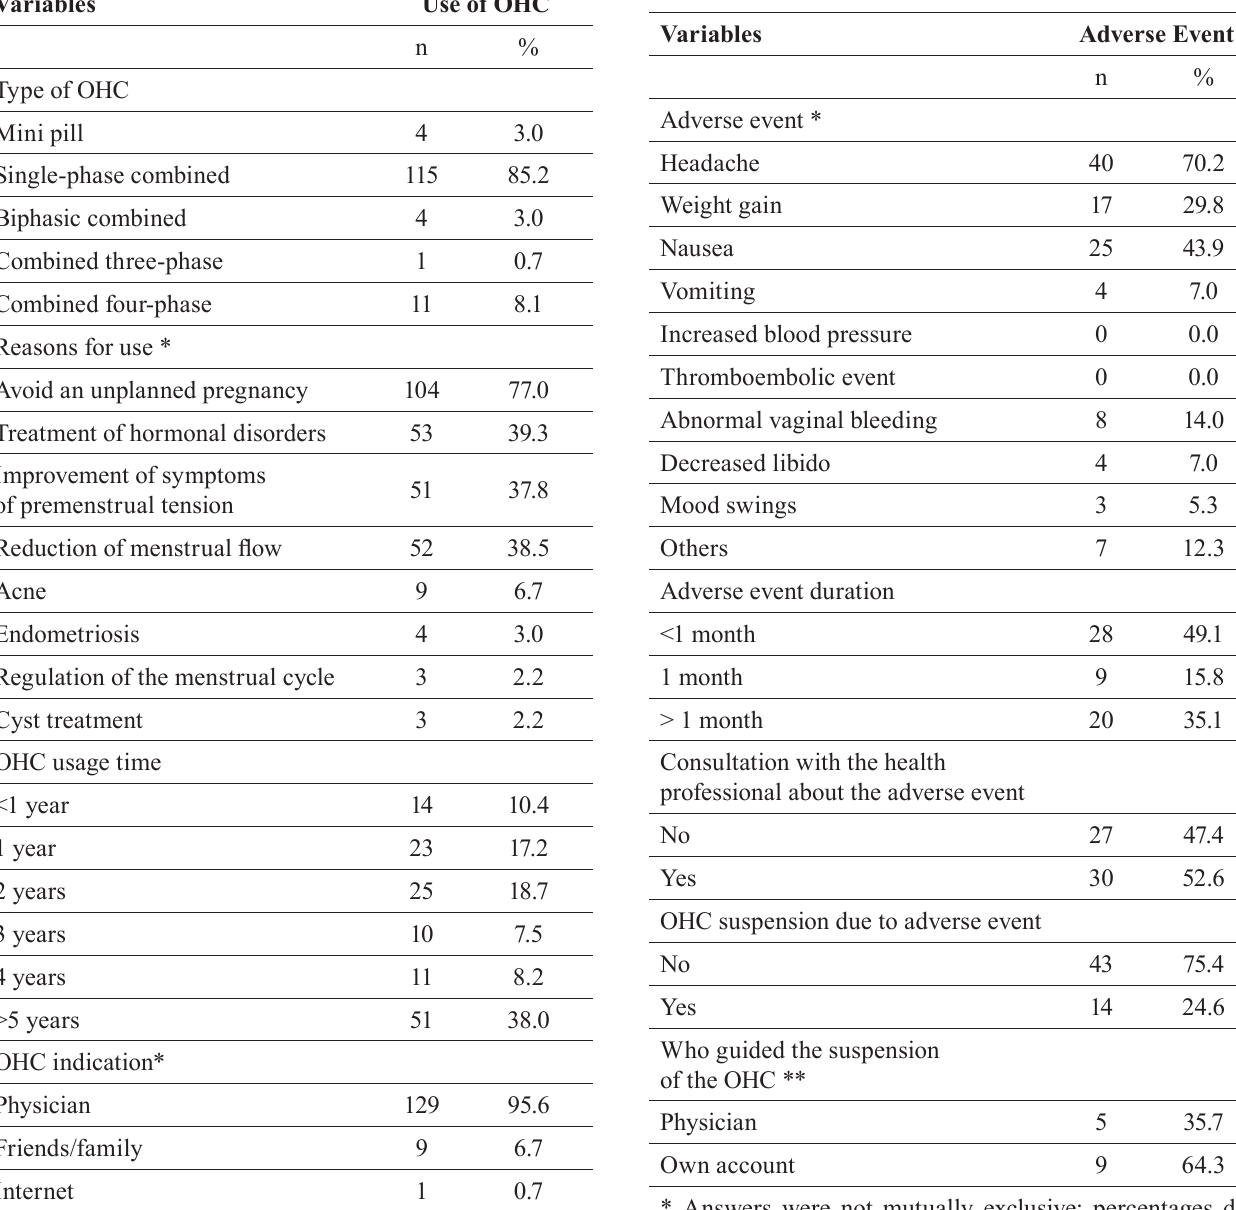
TABLE III - Profile of the use of oral hormonal contraceptives among pharmacy students (n = 135)